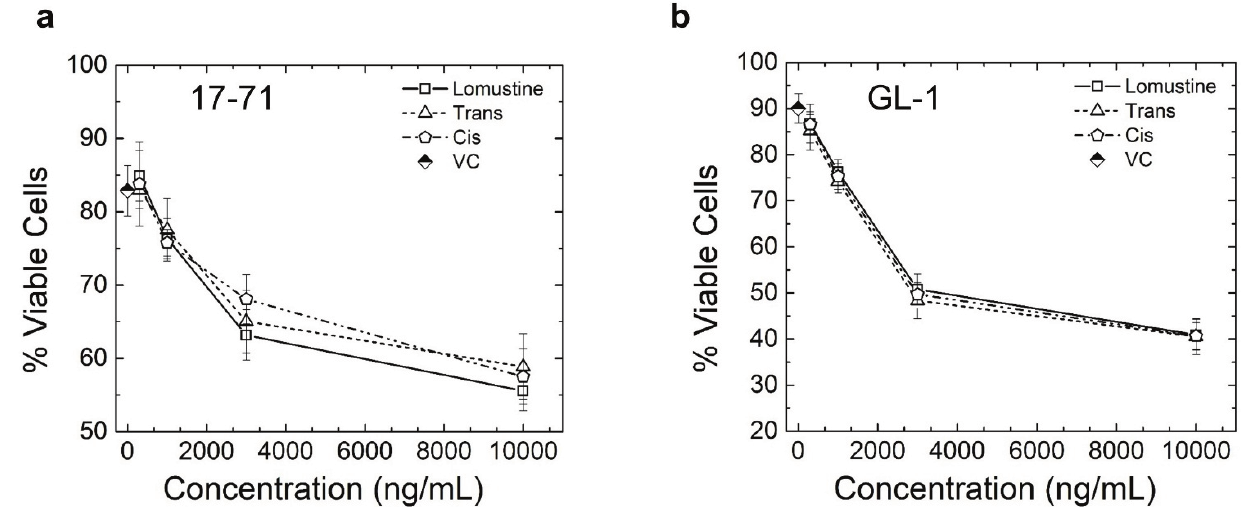
Figure 4. Graphs showing the percent viable cells obtained from Annexin/PI assay in 17–71 ( a ) and GL-1 ( b ) cells at 48 h. Vehicle control (VC) was 0.1% methanol. The results show the mean and standard deviation of three independent experiments (n =